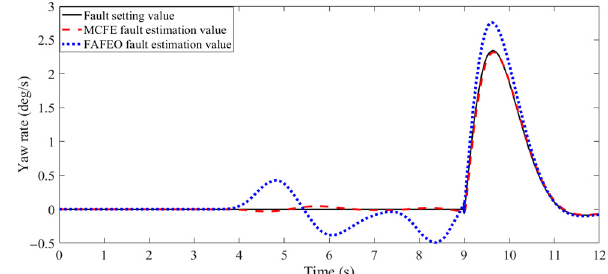
Figure 14 Fault estimation curve of the yaw rate sensor